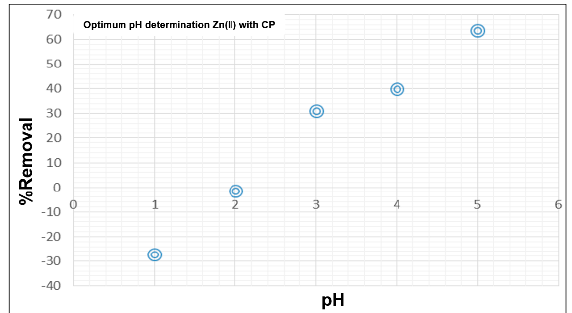
Figure 6. Determination of the optimum pH in the removal of Zn(II) with CP.